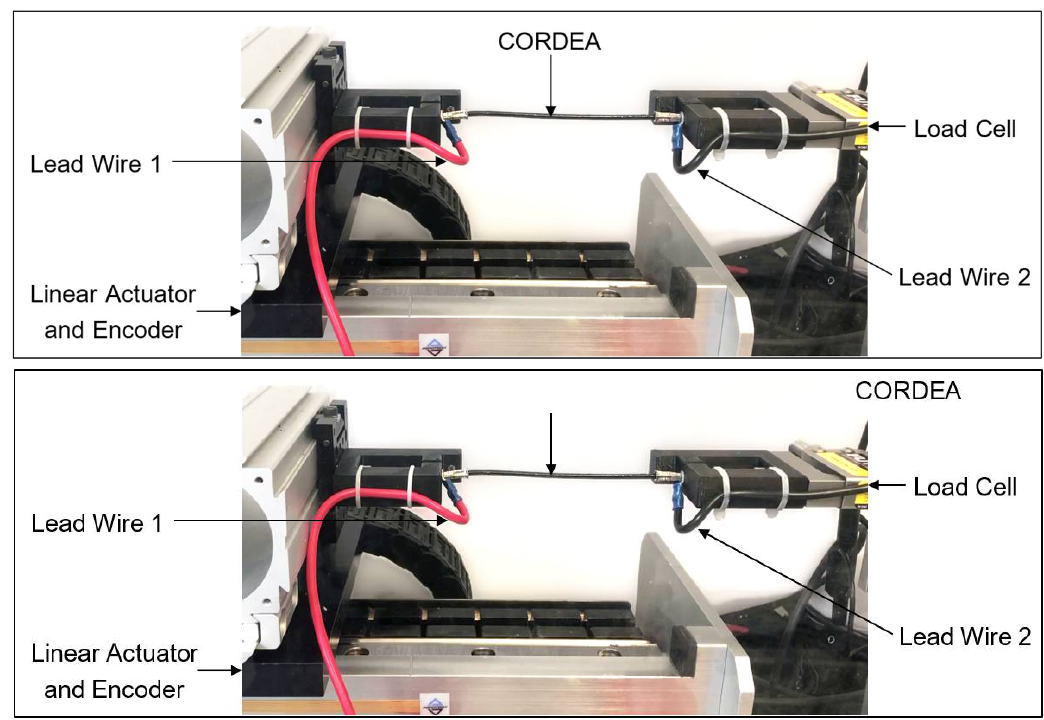
Figure 10. Picture of the experimental setup. The lead wires connect to the high voltage amplifier or the LCR-bridge, depending on the experiment which is conducted.